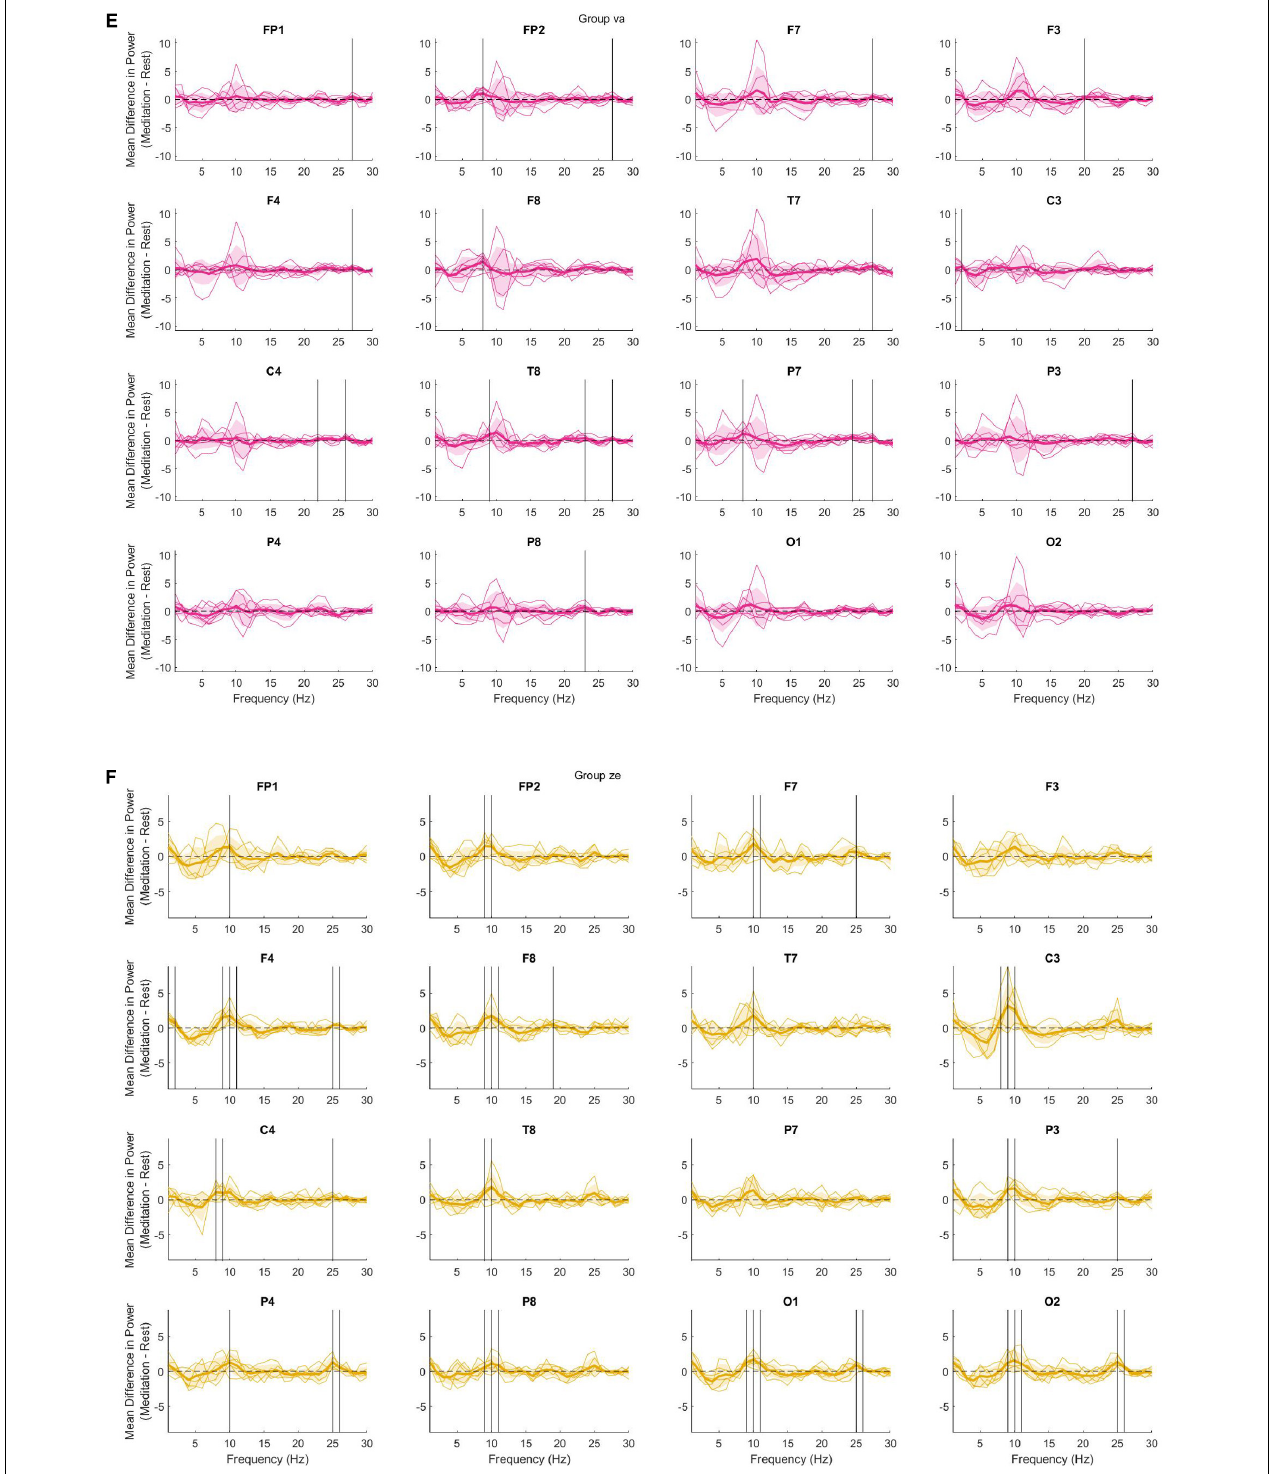
FIGURE 2 | The difference (meditation minus mind wandering) in power across frequency bands. Thin colored lines represent a single participant, and the bold-colored line indicates the mean. The shaded regions indicate 1 standard deviation from the mean. Vertical black lines indicate a significant difference between conditions at the 0.05 level with bootstrap statistics and with false discovery rate (FDR) correction. (A) dzogchen; (B) shamatha; (C) visualization; (D) tonglen; (E) vipassana; and (F)